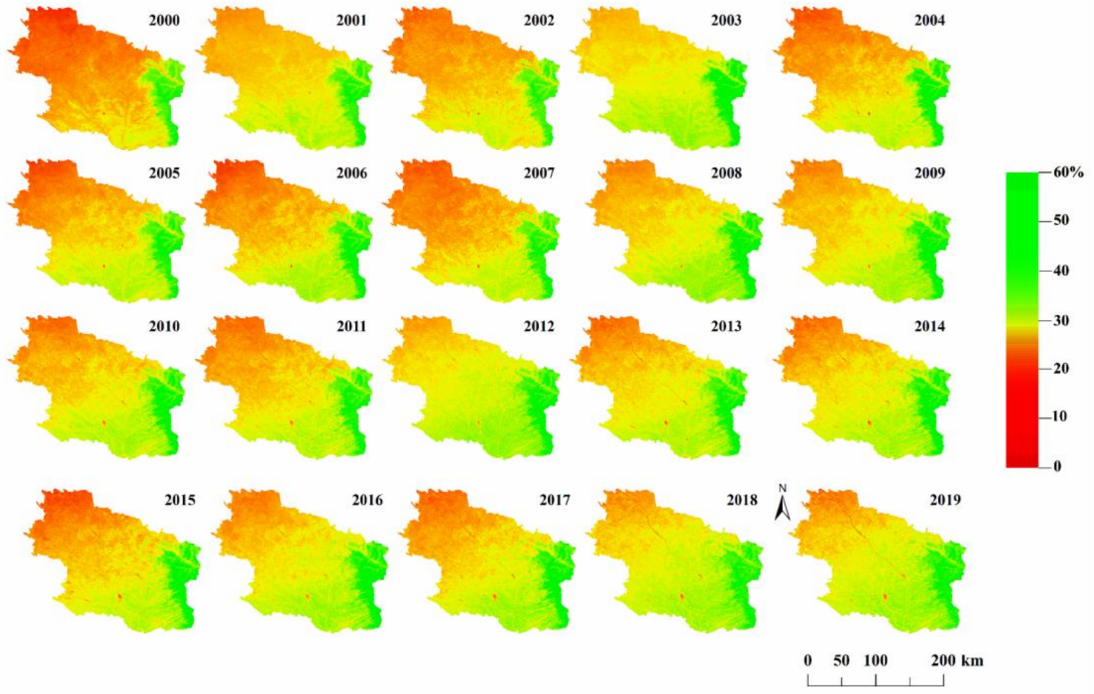
Figure 6. Annually spatial variation records of Qingyang from 2000 to 2019. The linear regression slope and significant value of τ are shown in Figure 7. A similar spatial trend was obtained from both coefficients. For the slope coefficient, 96.71% of pixels showed a positive trend while 3.29% were negative. For Kendall’s τ coefficient, 95.63% of the grids were positive and 4.37% were negative. Browning mainly occurred in the southeast part of Zhengyuan and Zhengning counties. Negative trends were also observable in distinct locations along the north boundary of Huan